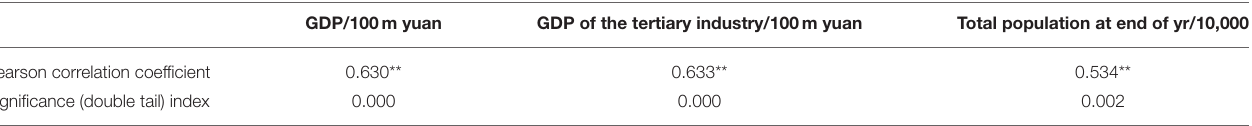
TABLE 6 | Correlation index statistics of the number of provincial